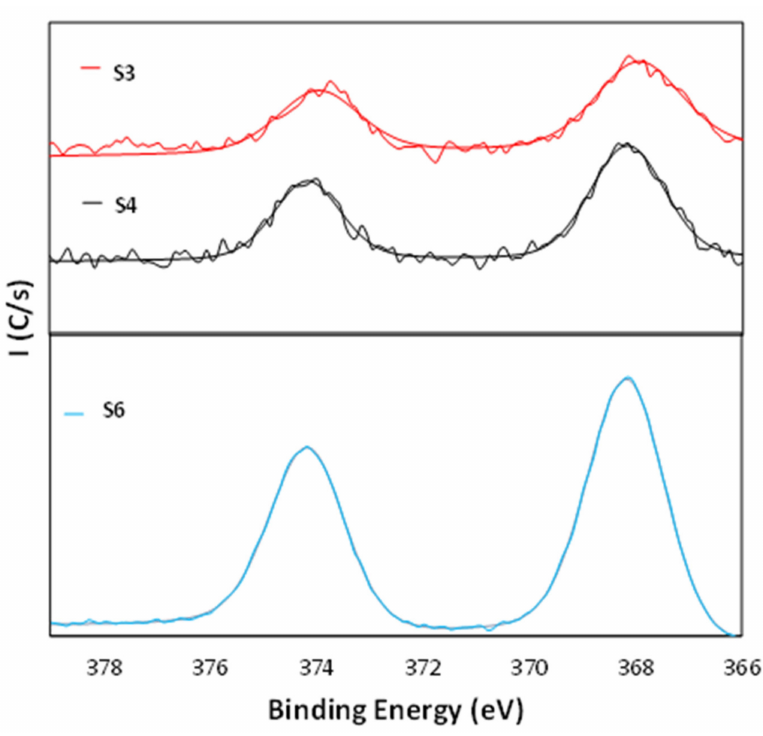
Figure 4. Ag 3d core level XPS spectra for the samples S3, S4, and S6.